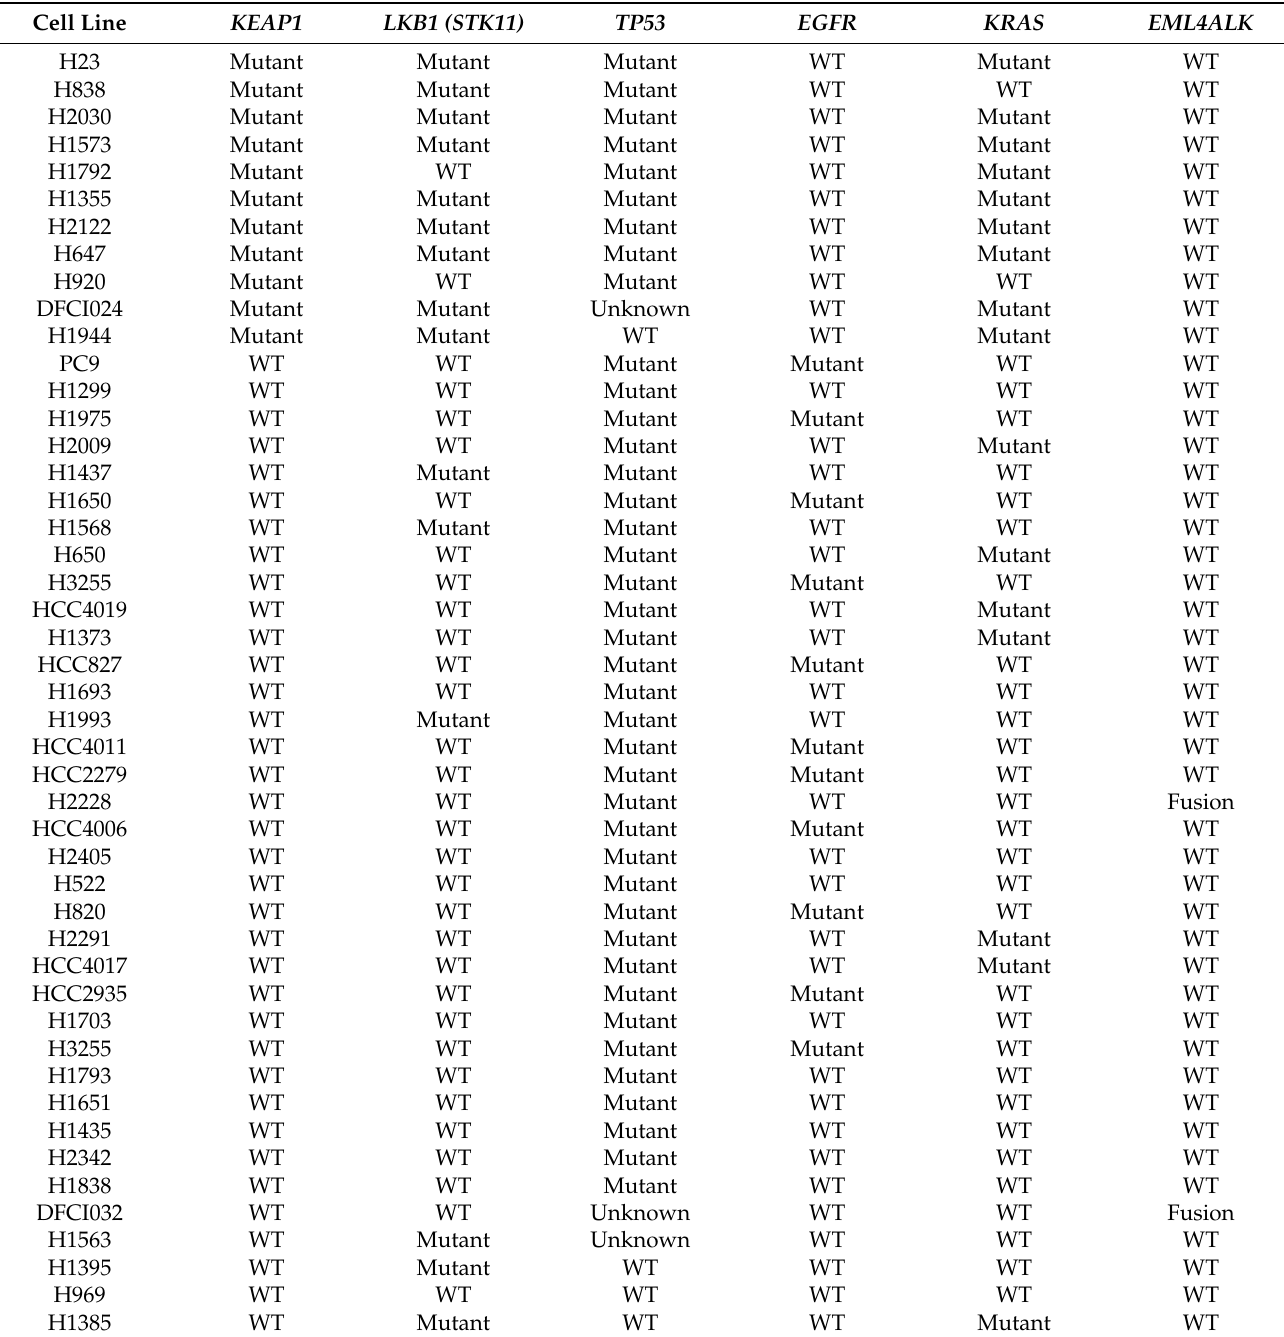
Table A1. Profiled lung adenocarcinoma cell